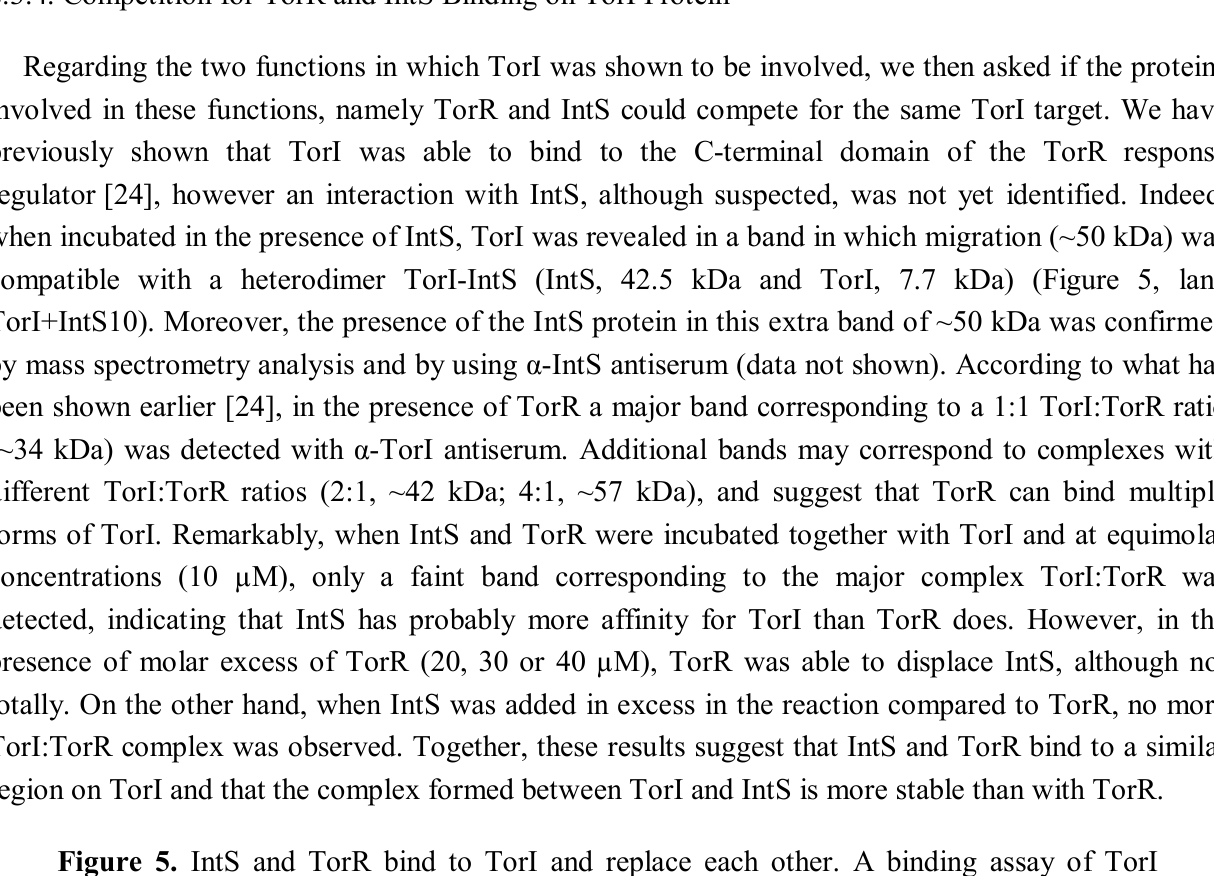
Figure 5. IntS and TorR bind to TorI and replace each other. A binding assay of TorI (10 µM) in the presence of various IntS and/or TorR concentrations, as indicated, was performed using BMH as a crosslinker (see the Experimental Section). Major TorI-IntS and TorI-TorR complexes are pointed by